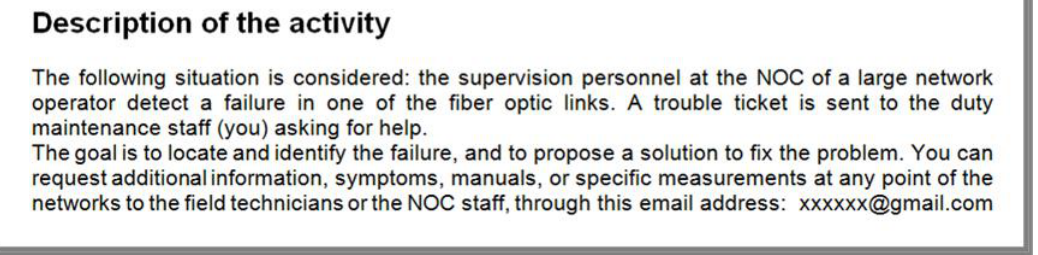
Fig. 1.: Instructions given to students to start the